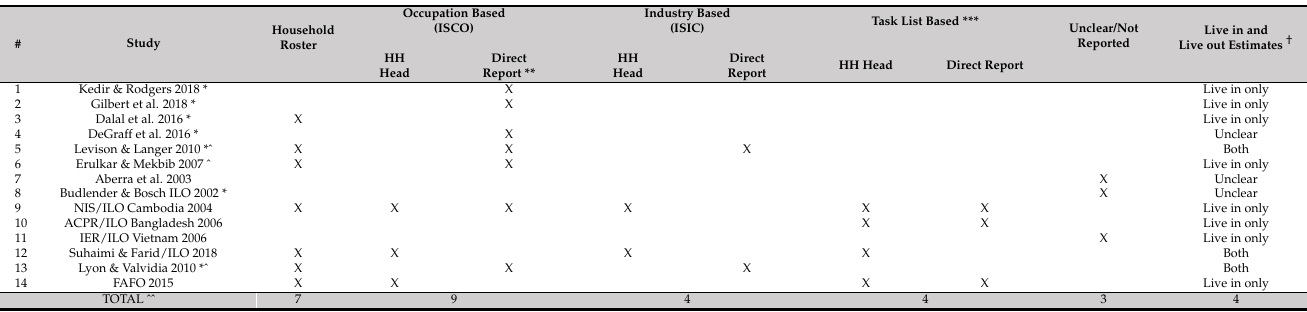
Table 2. Prevalence measurement methods and question modules in included studies ( n = 14)